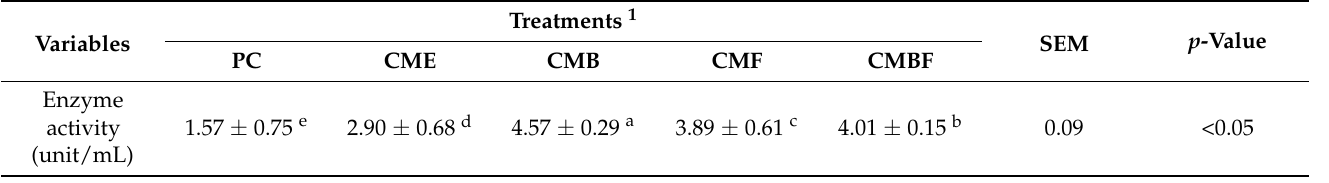
Table 1. Proteolytic activity of the Cordyceps militaris mushroom extract.